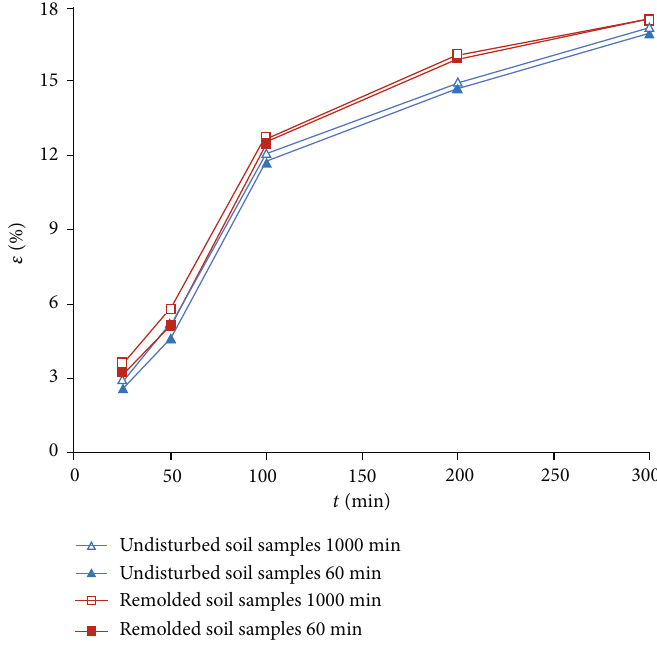
Figure 11: Strain-time curves of undisturbed and reconstituted soil samples.